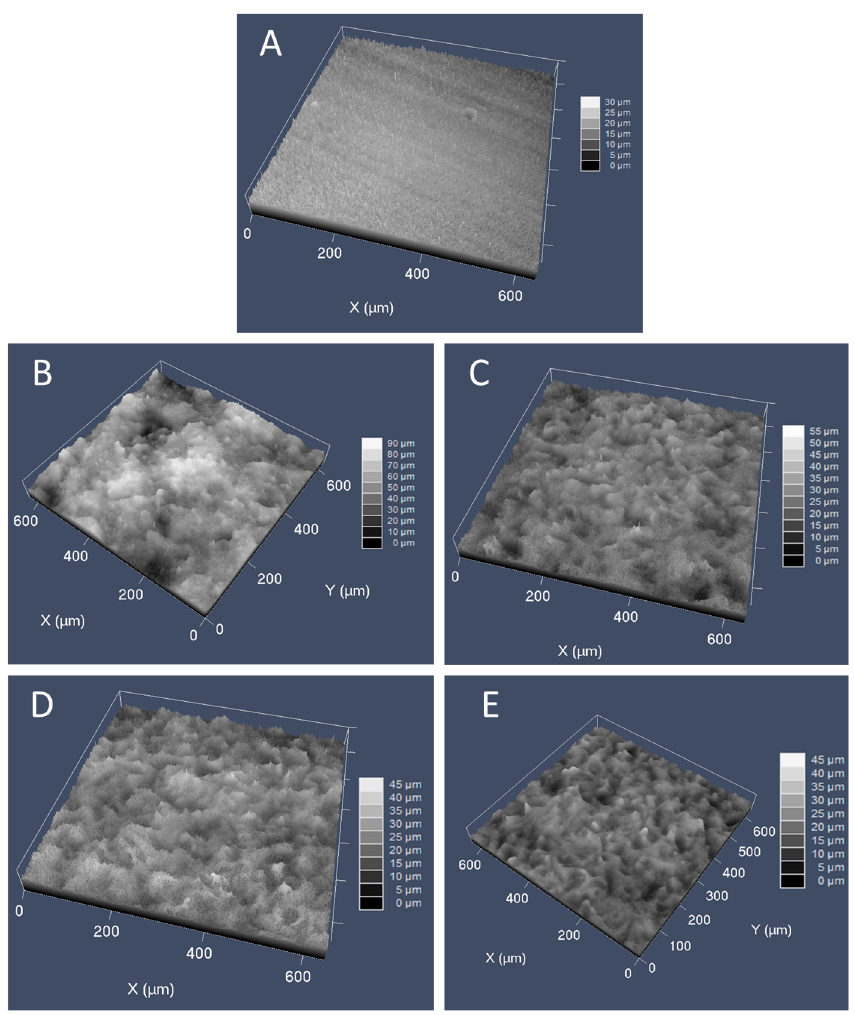
Figure 6. Surface topography images of Ti-6Al-4V plate ( A ), HAp by plasma spray coating ( B ) and coatings by CoBlast TM with HAp ( C ), 80/20 ( w / w %) of HAp/BaTiO 3 with BT cubic nanopowders ( D ) and tetragonal micropowders ( E ). Images were obtained with a confocal laser microscope (the vertical scale of each of the images is set from black to white (0 to 45 µm) and the colour changes every 5 µm).